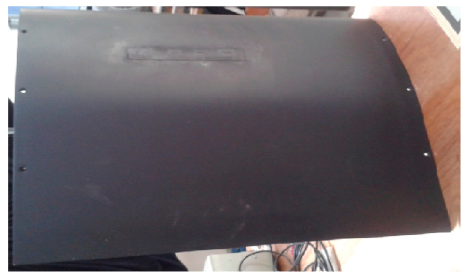
Figure 7. Detachable airfoil with synthetic jet actuator used in active flow controlled (AFC) wind turbine design [87].